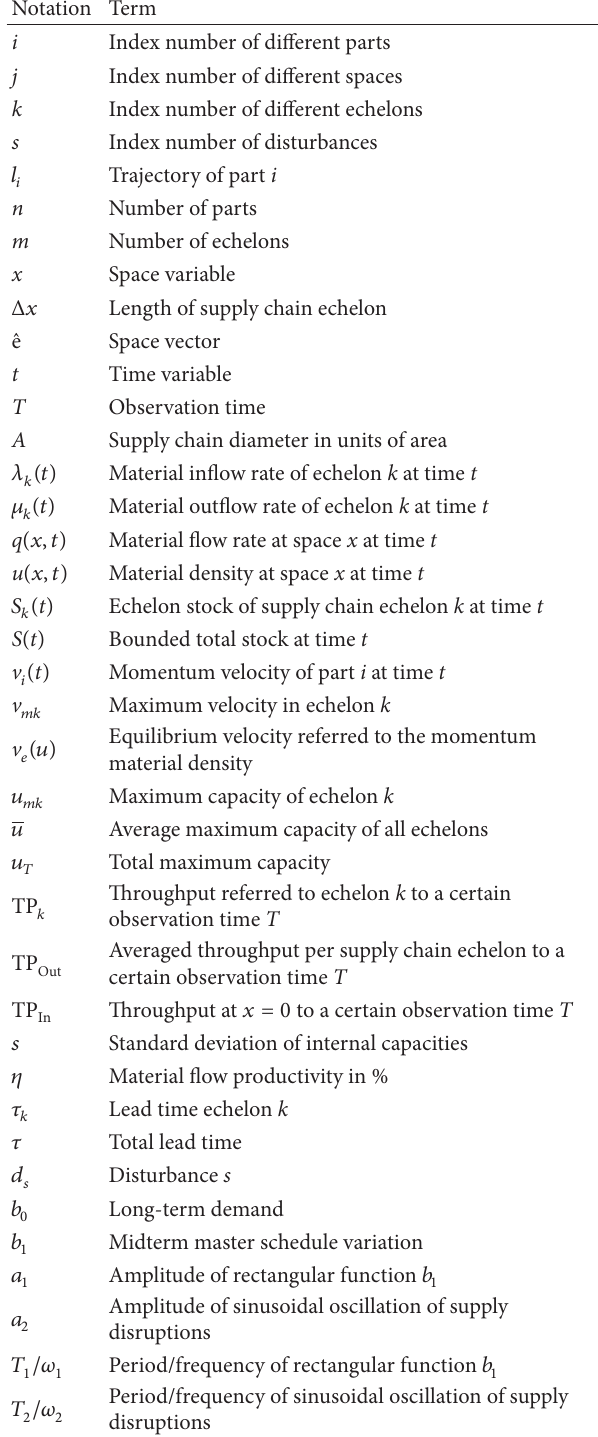
Table 1: Notation